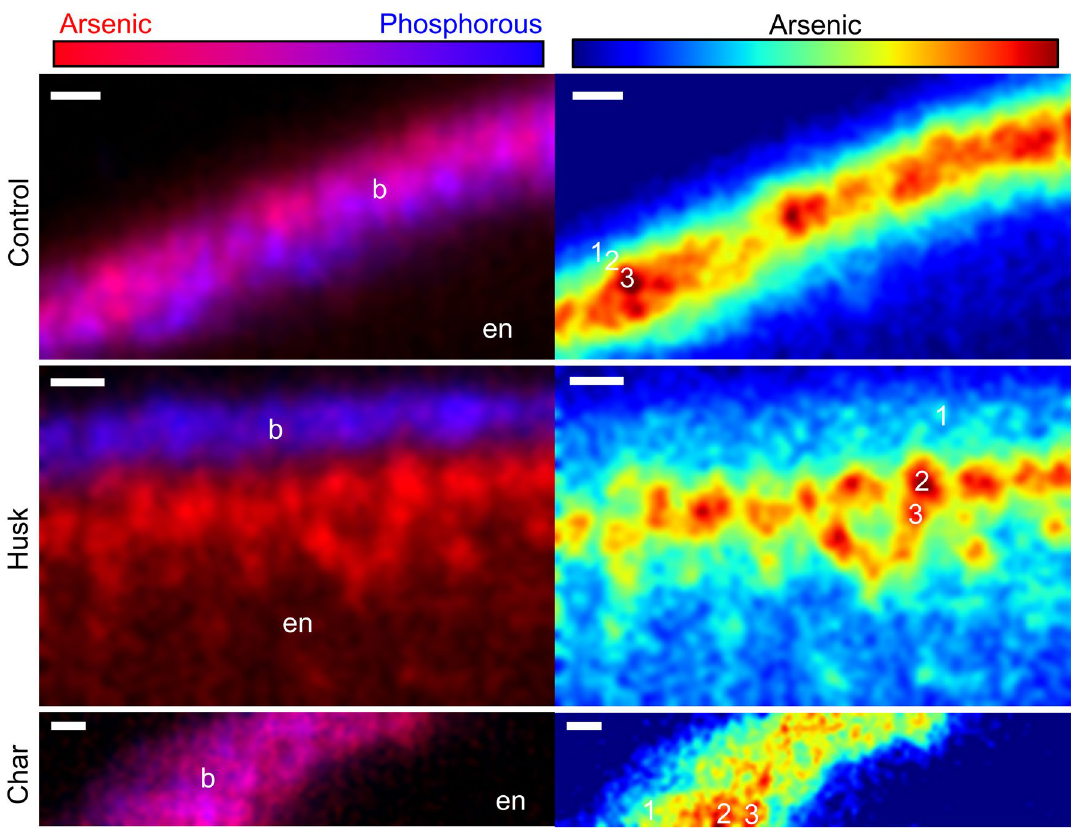
Figure 4. Effect of Si-rich soil amendments on As localization in IR66 rice grains. Bicolor plots show distribution of As (red) and P (blue) at the edge of a longitudinal thin section. For As plots, warmer colors correlate with higher concentrations of As. Grain from each plant was 44%, 83%, and 39% organic As for control, husk, and charred husk (‘Char’) treatments, respectively. Numbered locations indicate μXANES scans and linear combination fit results are shown in Table S3. Scale bar is 20 μm. b, bran; en,